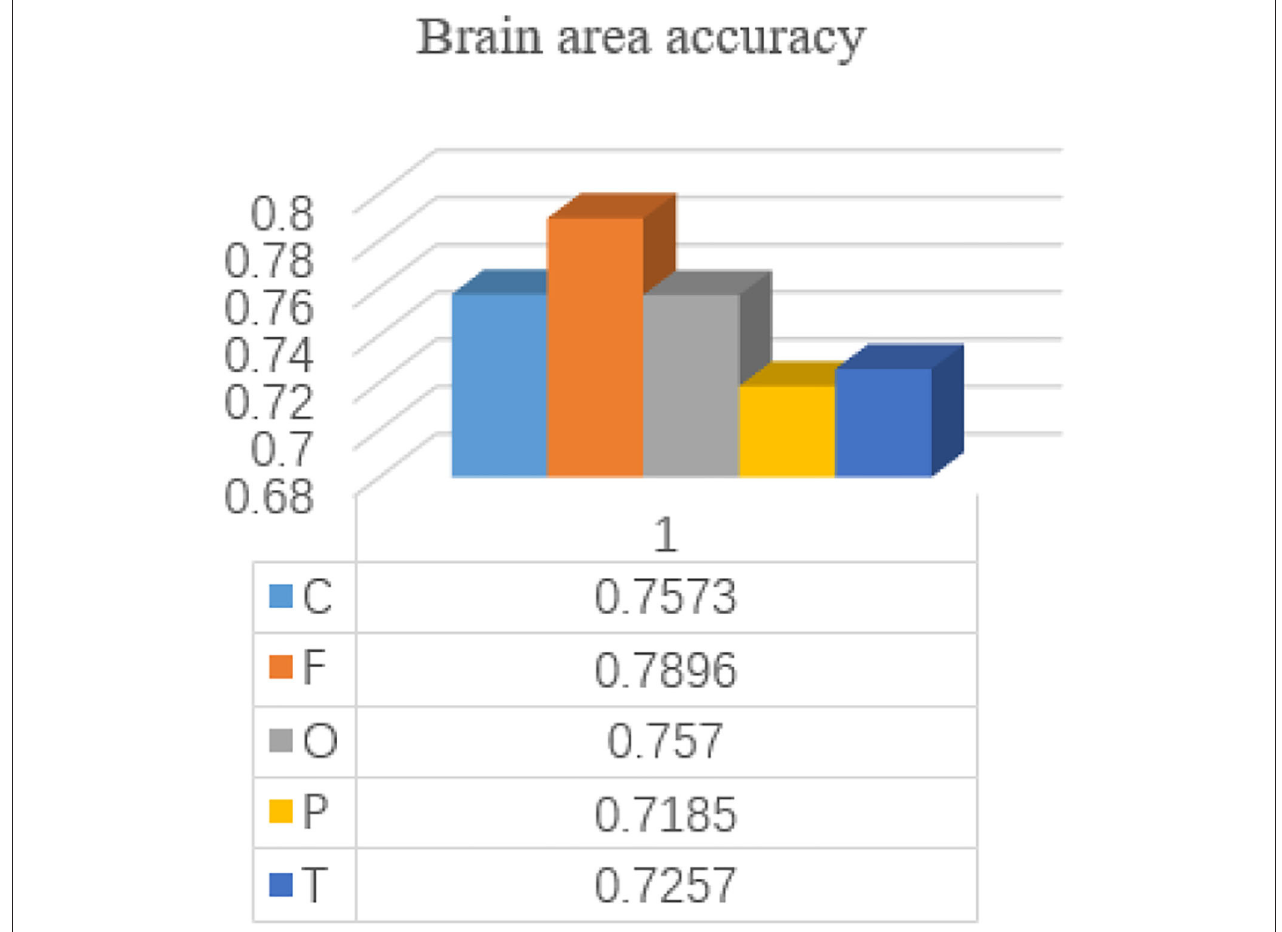
FIGURE 7 | The accuracy of different brain regions in identifying people with